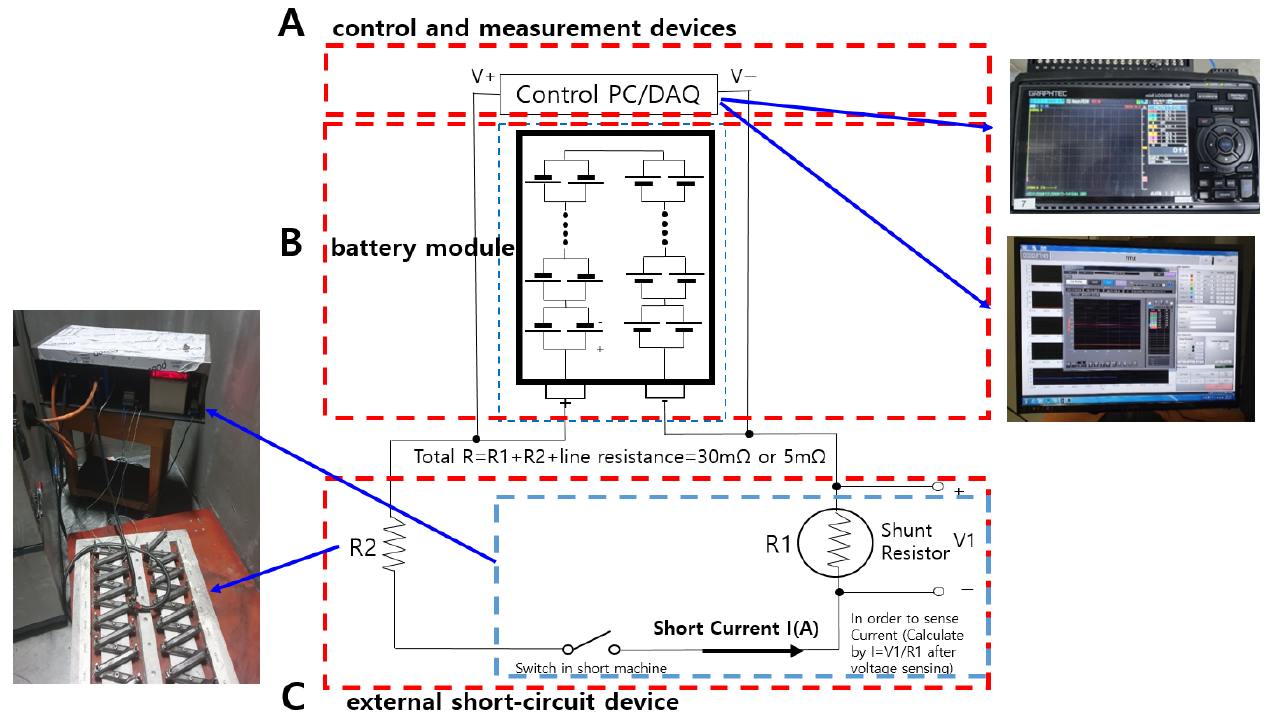
Figure 2. Configuration of test devices for battery module.